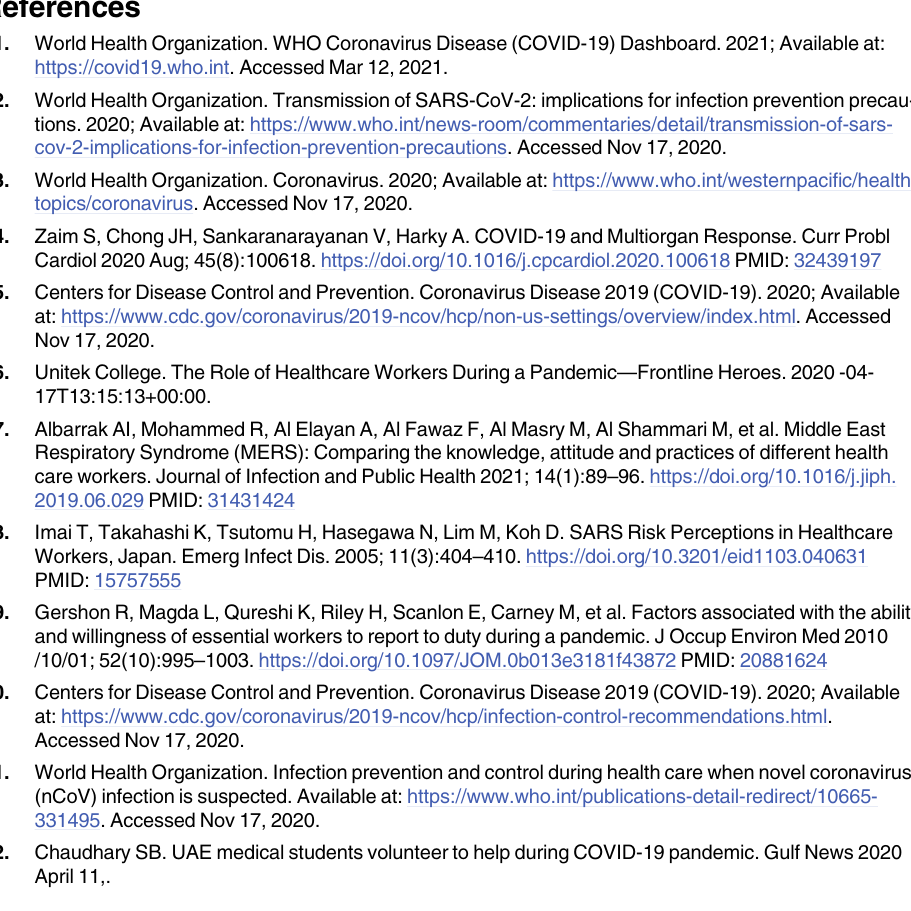
S4 Table. Incentives which increase willingness to work in current or future